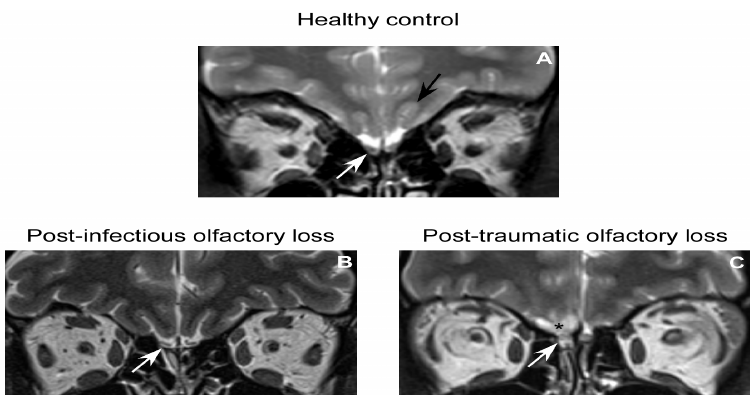
The OBs (white arrow) are located above the cribriform plate of the ethmoid bone, under the frontal lobes. The olfactory sulcus is indicated by a black arrow. The OB is decreased in patients suffering